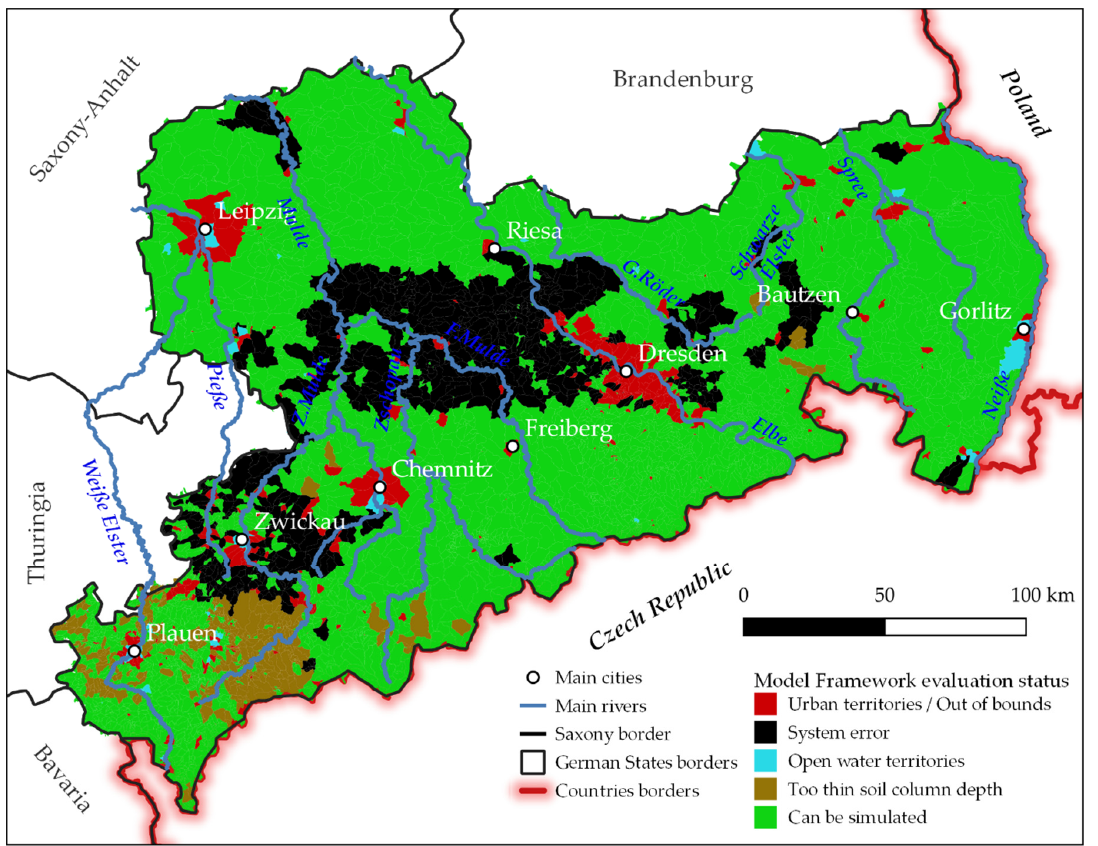
Figure 4. Overview of the approach performance in the Free State of Saxony.